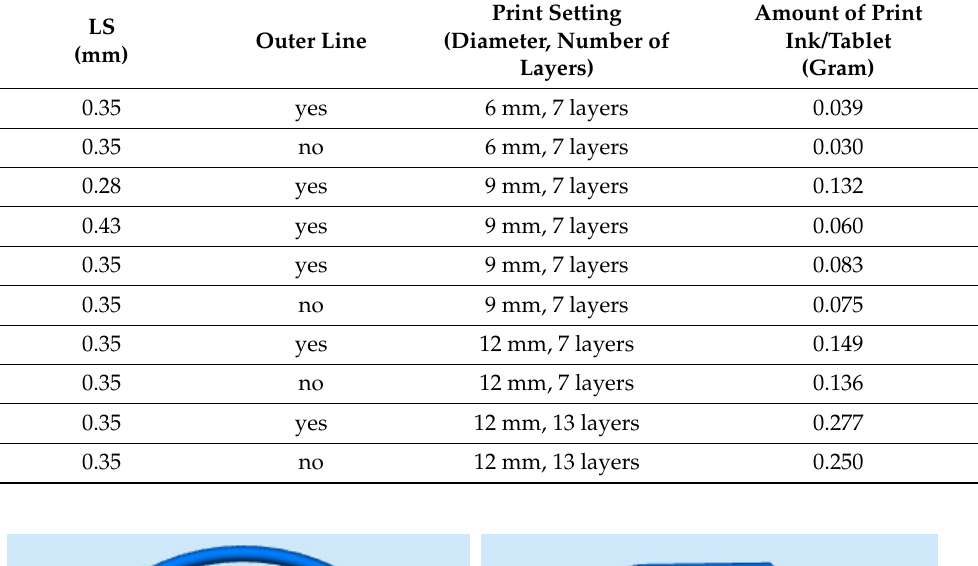
Table 1. Overview of print dimensions and amount of print ink per formulation. The print pattern is provided in Figure 1.